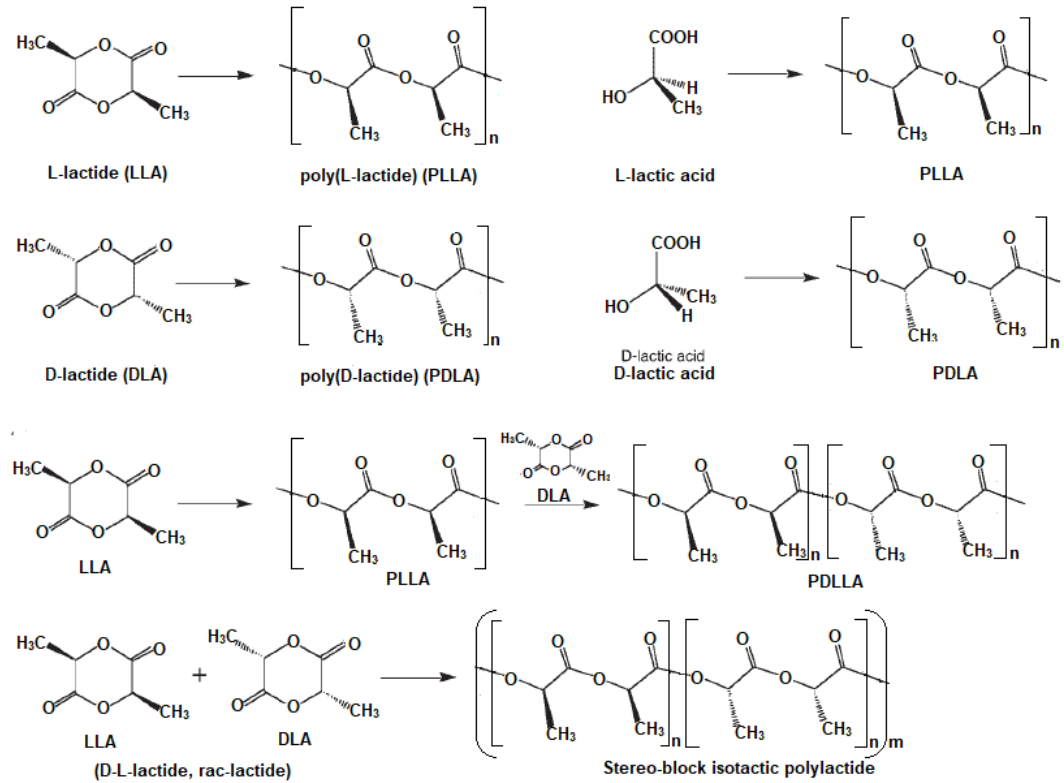
Figure 1. Synthesis and chemical structures of lactide stereoisomers and copolymers. Table 1. Physical properties of